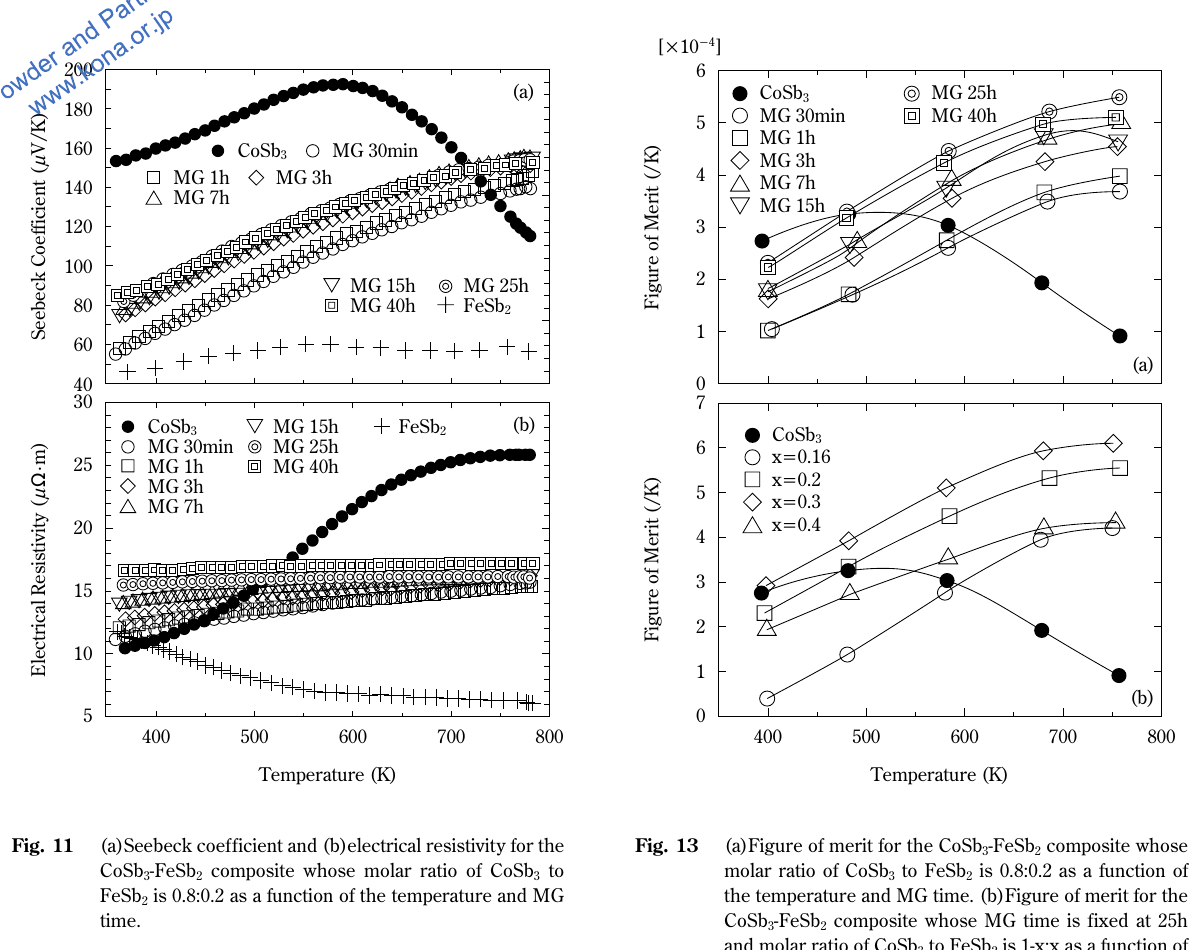
to FeSb varied from 0.84:0.16 to 0.6:0.4. MG time was 2 fixed at 25h. Figure 13 (b) shows the temperature and molar ratio dependence of the Z for the CoSb FeSb composite. The sample whose molar ratio of 2 CoSb to FeSb is 0.7:0.3 has a maximum Z of 3 2 6.1 (cid:3) 10 (cid:5) 4 K (cid:5) 1 at 756K.